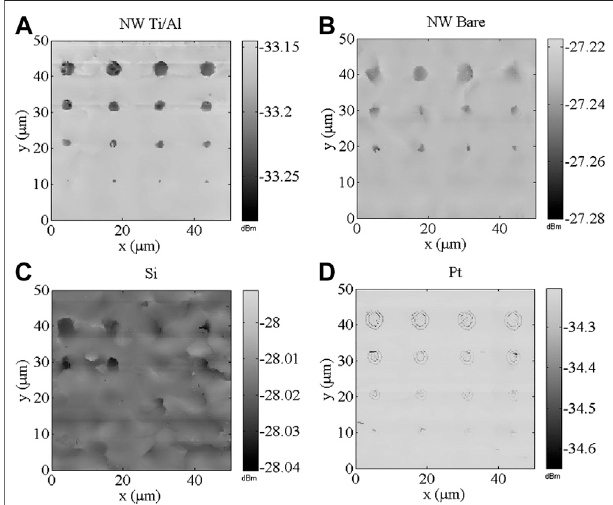
FIGURE 5 | S 11 image with four different probes indicates a minimum sensitivity. [40] (A) Scan results for the Ti/Al NW probe over DUT showing the change in the amplitude of the microwave re fl ection coef fi cient S11. All micro- capacitors are present in the image, indicating sensitivity to at least 0.7 fF. (B) S11image withabare NW probe indicates a minimumsensitivityof 3 fF. (C) S11 image with Si probe indicates a minimum sensitivity of 6 fF. (D) S11 image with Pt probe indicates a minimum sensitivity of 0.7 fF. All scans areplottedwithdifferent Z -axiscolorscalesforclarity.Allmicro-capacitorsare present in the image, indicating sensitivity to at least 0.7 fF [40]. Reproduced with permission from Appl. Phys. Lett. 104, 2 (2014). Copyright 2014 American Institute of